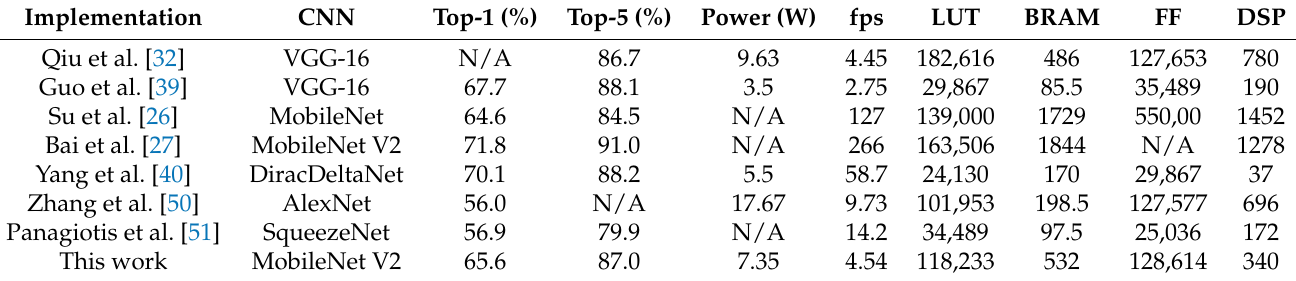
Table 11. Comparison to other CNN accelerators (N/A: Not